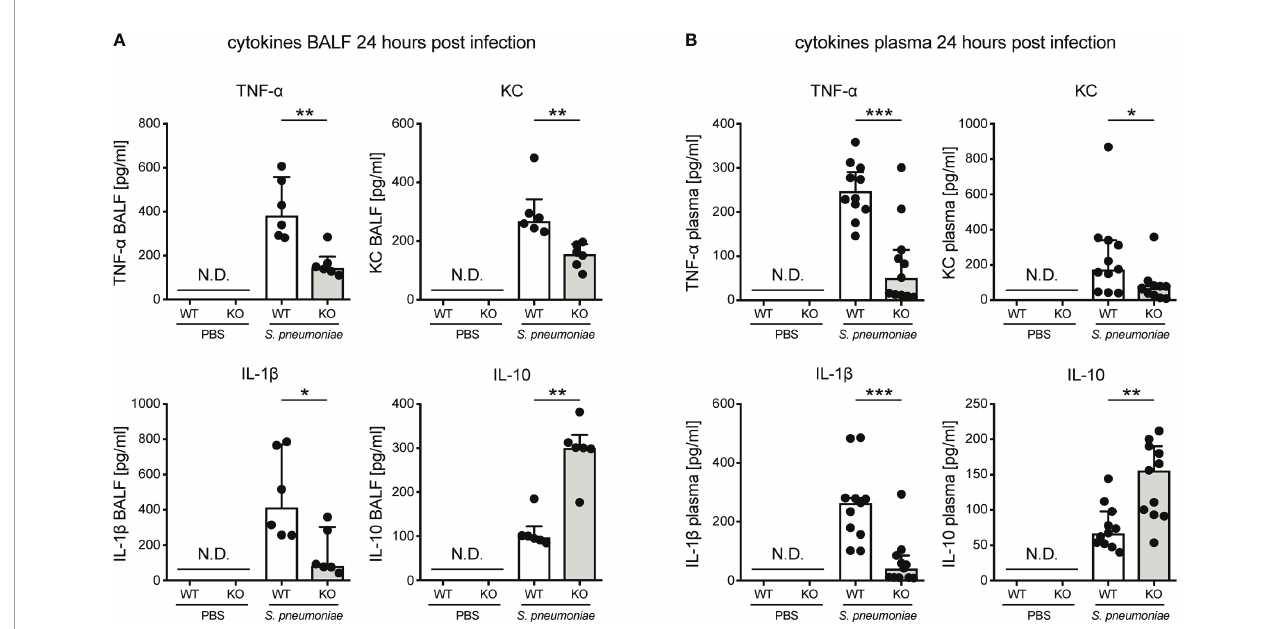
FIGURE 3 | Cytokines in bronchoalveolar lavage fl uid and plasma of myeloid KLF4 knockout and KLF4 wildtype mice 24 hours after transnasal infection with S. pneumoniae . Myeloid KLF4 knockout (KO) and KLF4 wildtype (WT) mice were transnasally inoculated with PBS or 5x10 5 CFU NCTC 7978 pneumococci. 24 hours after inoculation venous blood was sampled and BAL was performed. TNF- a , KC, IL-1 b and IL-10 was quanti fi ed in BALF (A) and plasma (B) using ELISA. Graphs show median with interquartile range of 6 mice, each (A) , or median with interquartile range of 11 mice, each (B) . Statistics: Mann-Whitney U test. *p < 0.05, **p < 0.01, ***p < 0.001. N.D., not